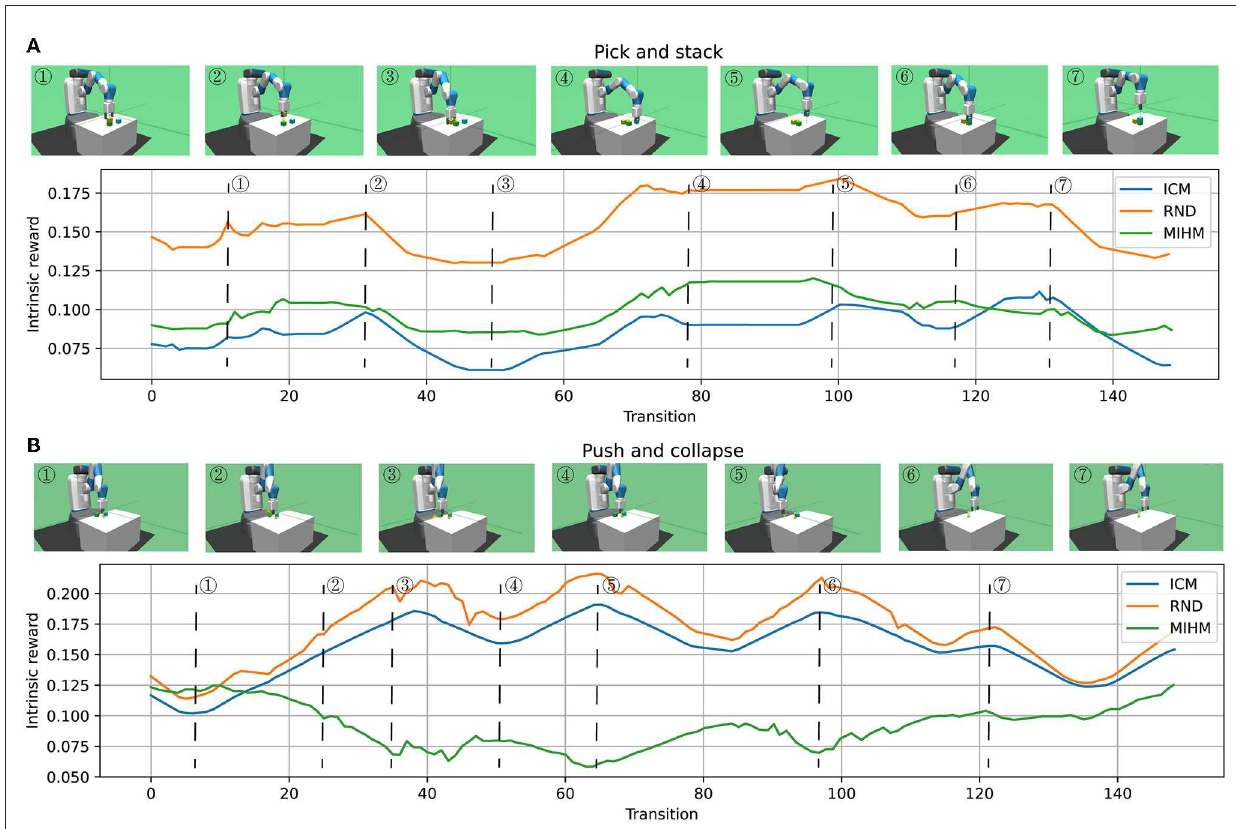
FIGURE5 The variations of intrinsic rewards when picking and stacking objects (A) and pushing objects off the table (B) . (A) Shows that ICM, RND and MIHM can effectively reward the novel and controllable behaviors. (B) Shows that ICM and RND wrongly reward the novel but uncontrollable behaviors. Comparatively, our MIHM can effectively discover and prevent the uncontrollable behaviors.